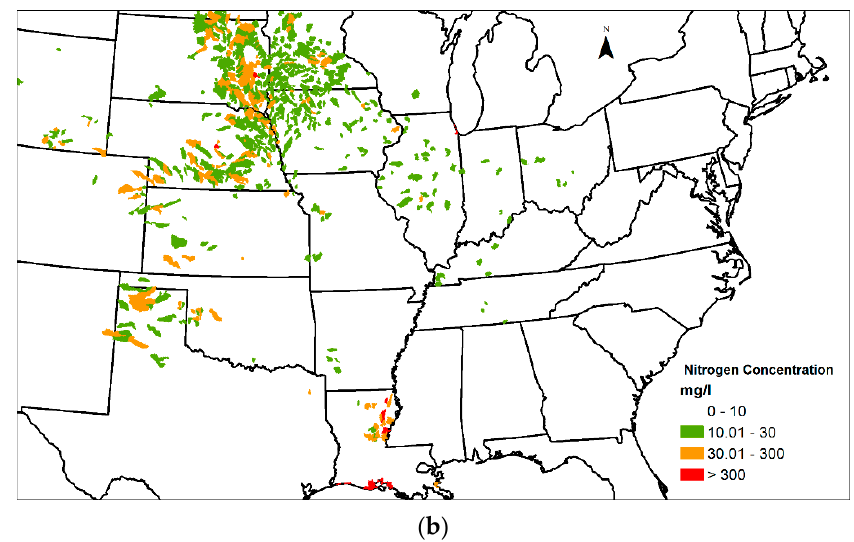
Figure 5. ( a ). Distribution of nitrogen concentration per catchment area for the 2015 mandate. ( b ) Distribution of nitrogen concentration per catchment area for the 2022 mandate.